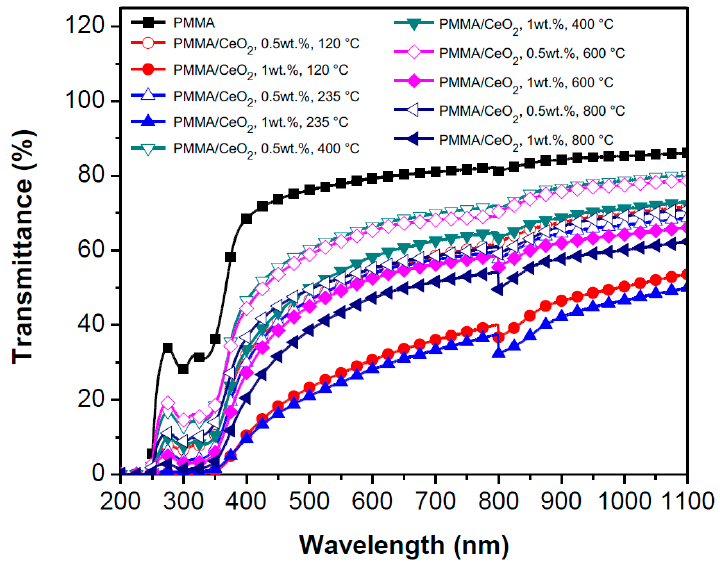
Figure 10. UV-Vis spectra of pure PMMA and PMMA/CeO 2 hybrid systems.